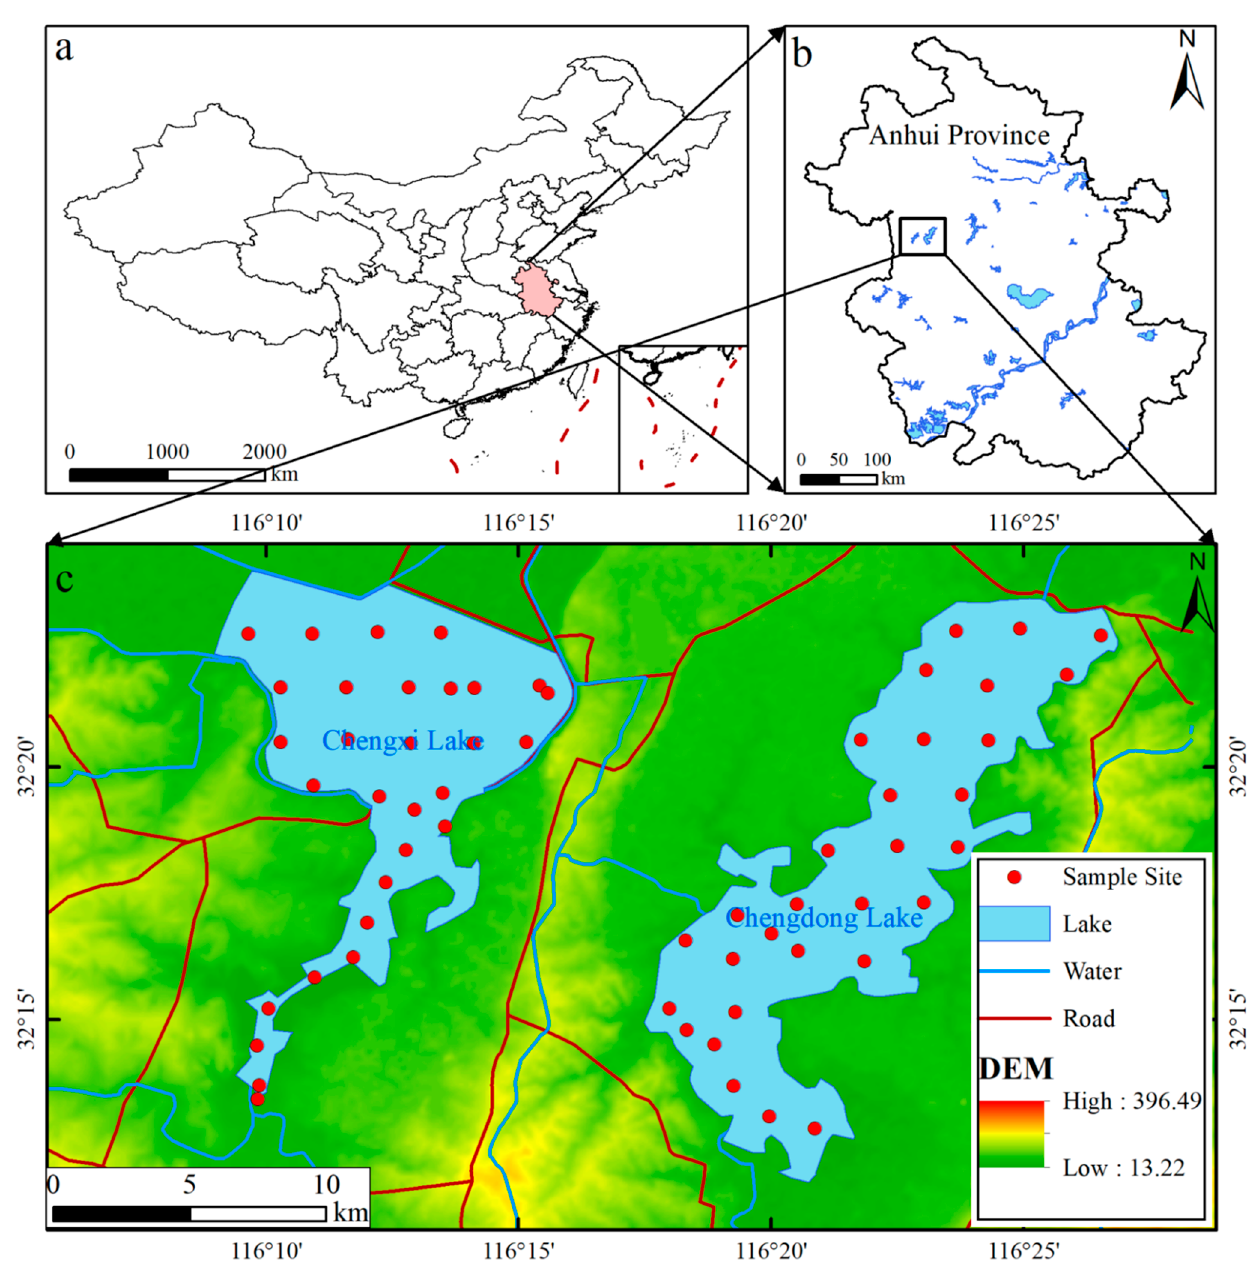
Figure 1. Location and distribution of sampling sites. ( a ) The geographical location of Anhui Province; ( b ) geographical location of the study area; ( c ) digital elevation models (DEM) around Chengdong Lake and Chengxi Lake and their relative positions. Spatial location of sampling points for lake sediment.